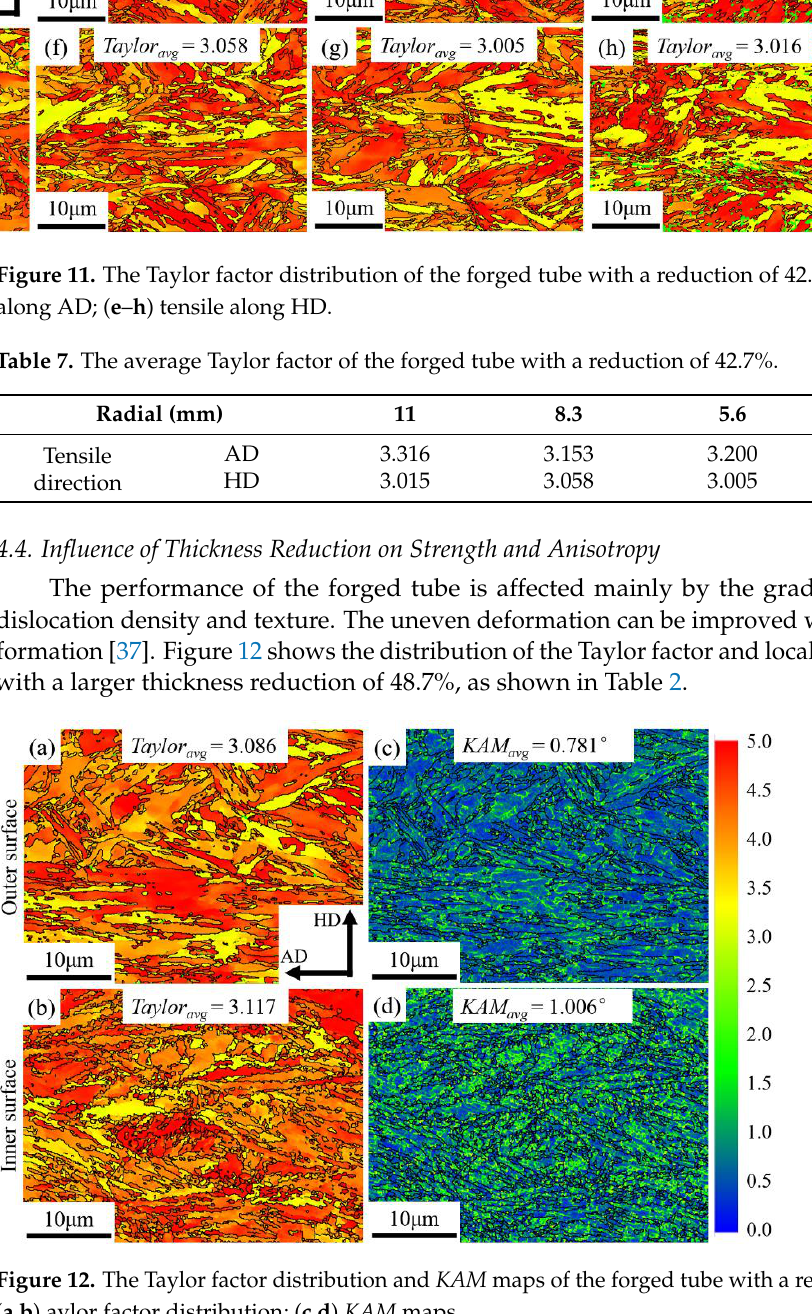
Figure 12. The Taylor factor distribution and KAM maps of the forged tube with a reduction of 48.7%: (a) and (b) Taylor factor distribution; (c) and (d) KAM maps.